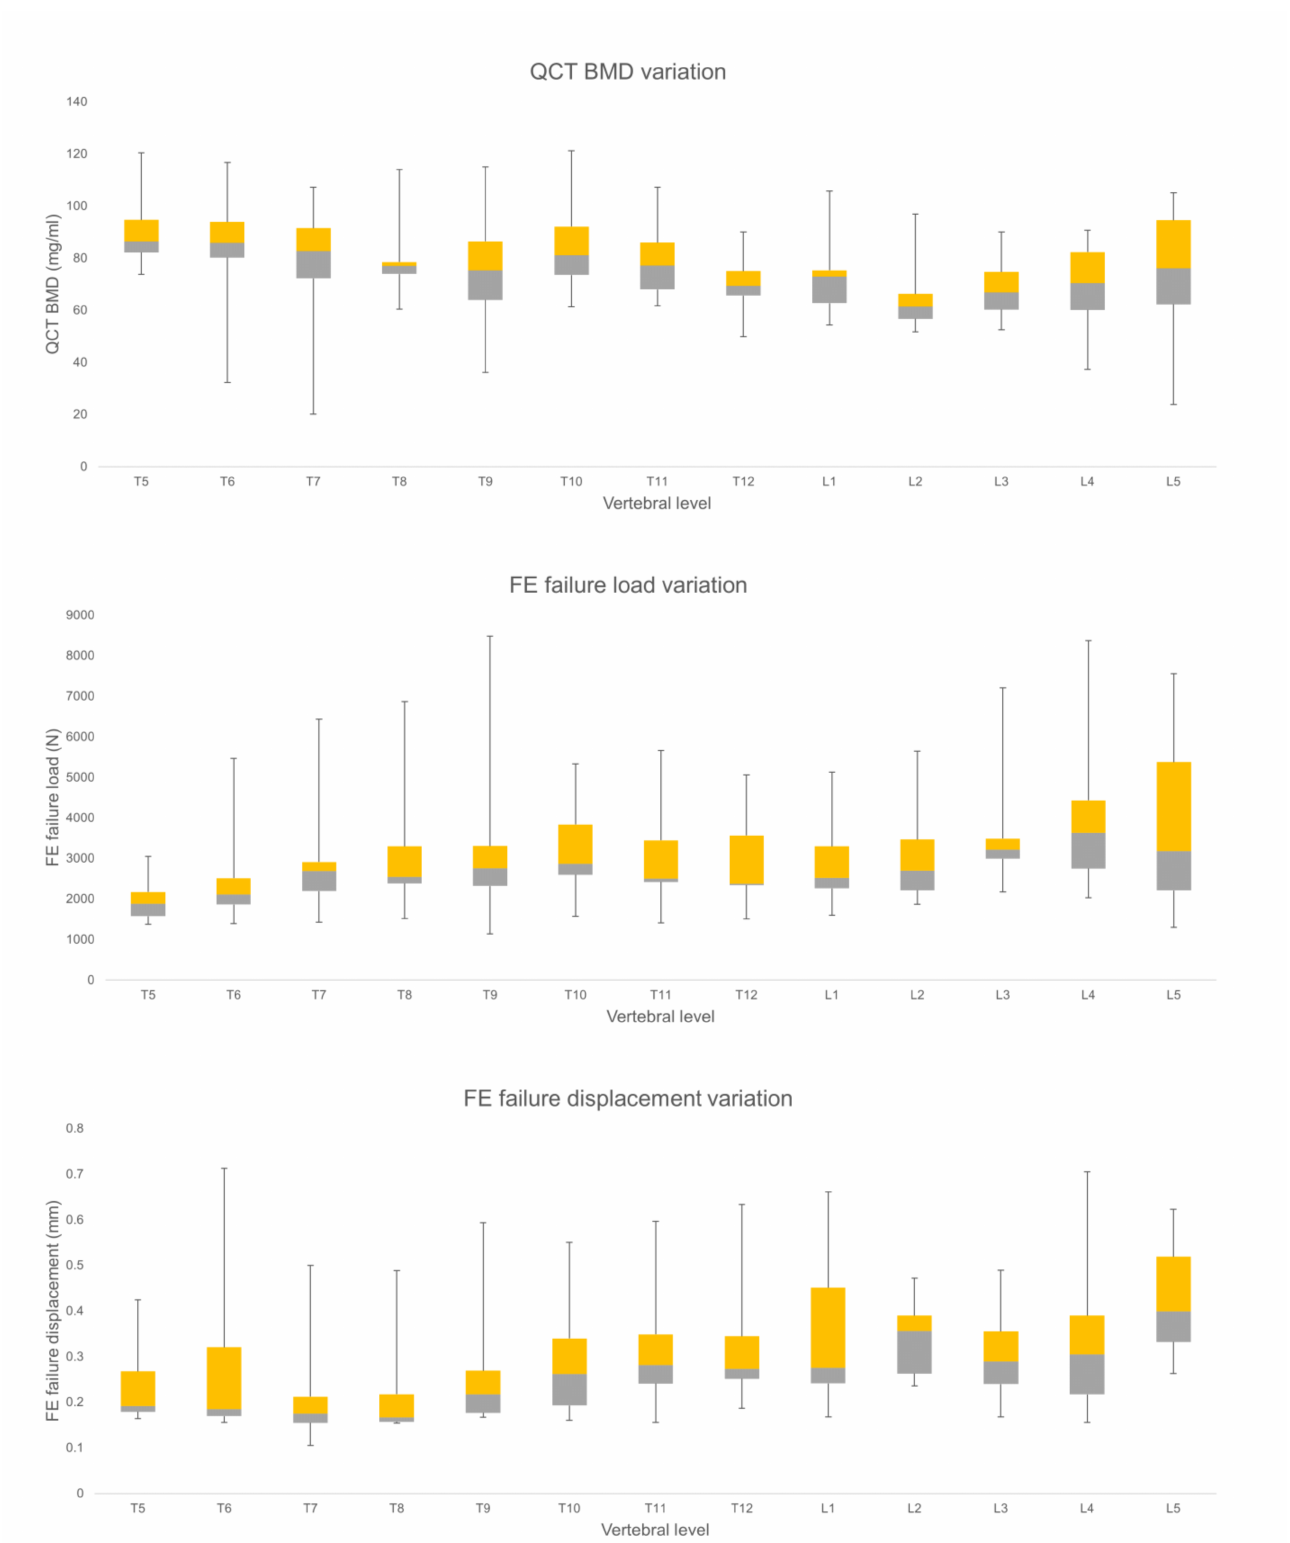
Figure 4. Finite element (FE), and Qct-BMD parameters variation for each vertebral level for healthy vertebrae (Median, quartile 2, 3, with the total range are